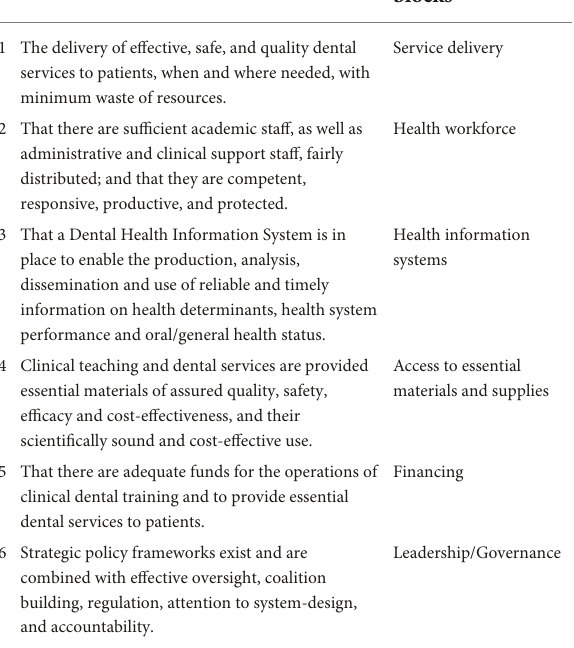
TABLE 2 Policy recommendation